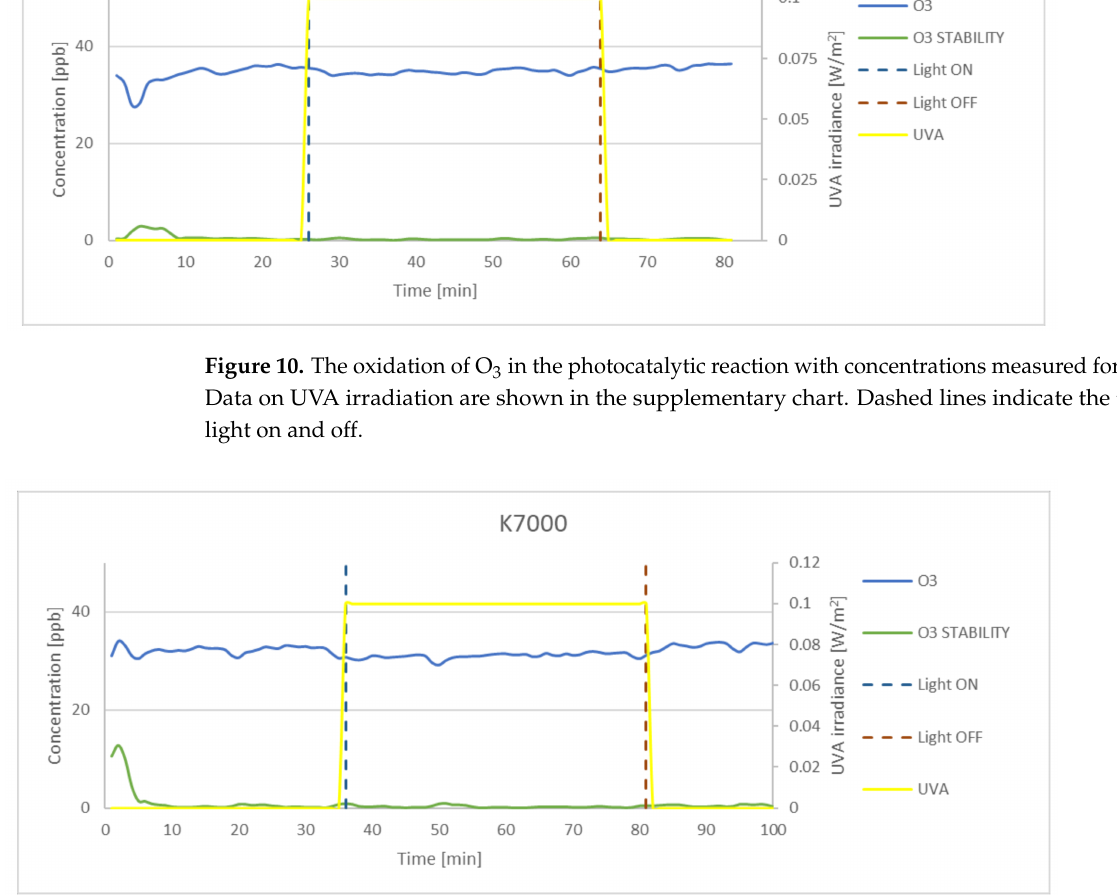
Figure 11. The oxidation of O 3 in the photocatalytic reaction with concentrations measured for K7000. Data on UVA irradiation are shown in the supplementary chart. Dashed lines indicate the time of light on and